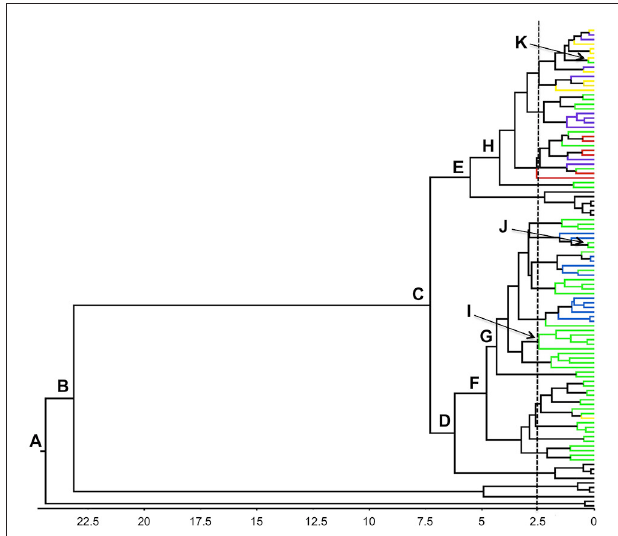
FIGURE 5 | Divergence history from the Oligocene to the present for Crocodylus species. Time to the most recent common ancestor, in million years (My), for Crocodylus moreletii and C. acutus from Mexico, estimated with BEAST and based on concatenated cytb-tRNAPro-tRNAPhe-d-loop. Mecistops cataphractus was used as outgroup (GenBank H21719, H21720). Also included are their sister species C. intermedius and C. rhombifer haplotypes, and C. niloticus as outgroup (shown as black branches on the tree). The colored branches represent the different genetic groups identified with STRUCTURE (microsatellites; K = 5) and following the color code as in Figure 2D . The letters at internal nodes refer to divergence times (see Table S9